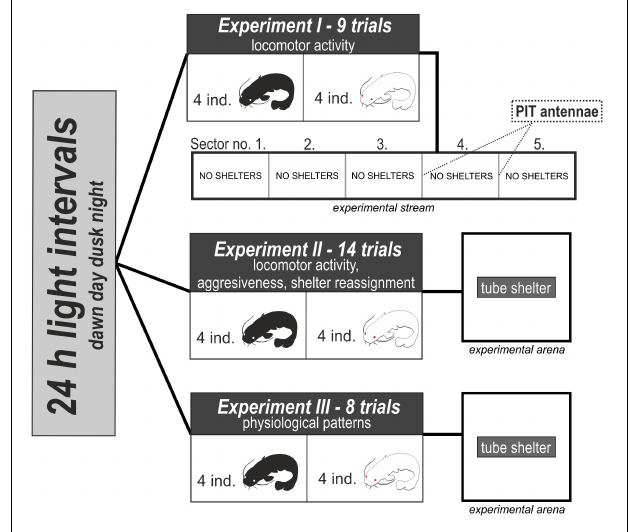
FIGURE 1 | Illustrative figure of the experimental